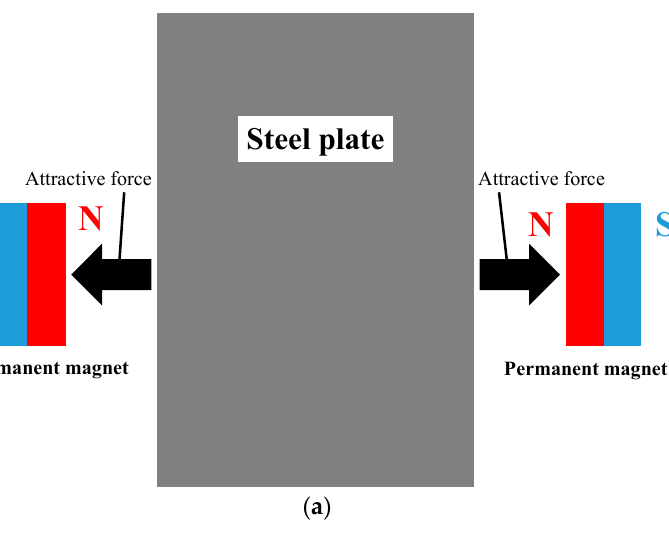
Figure 2. Schematic illustration of electromagnet.